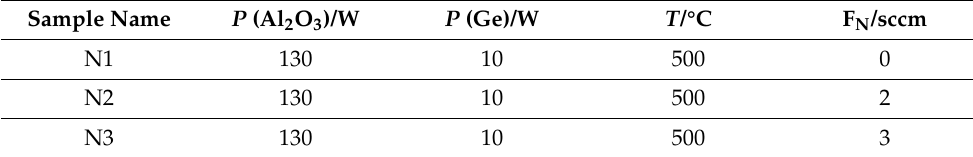
Table 1. Deposition parameters of the produced Ge QWs in the Al 2 O 3 matrix. F N —N 2 flow rate,